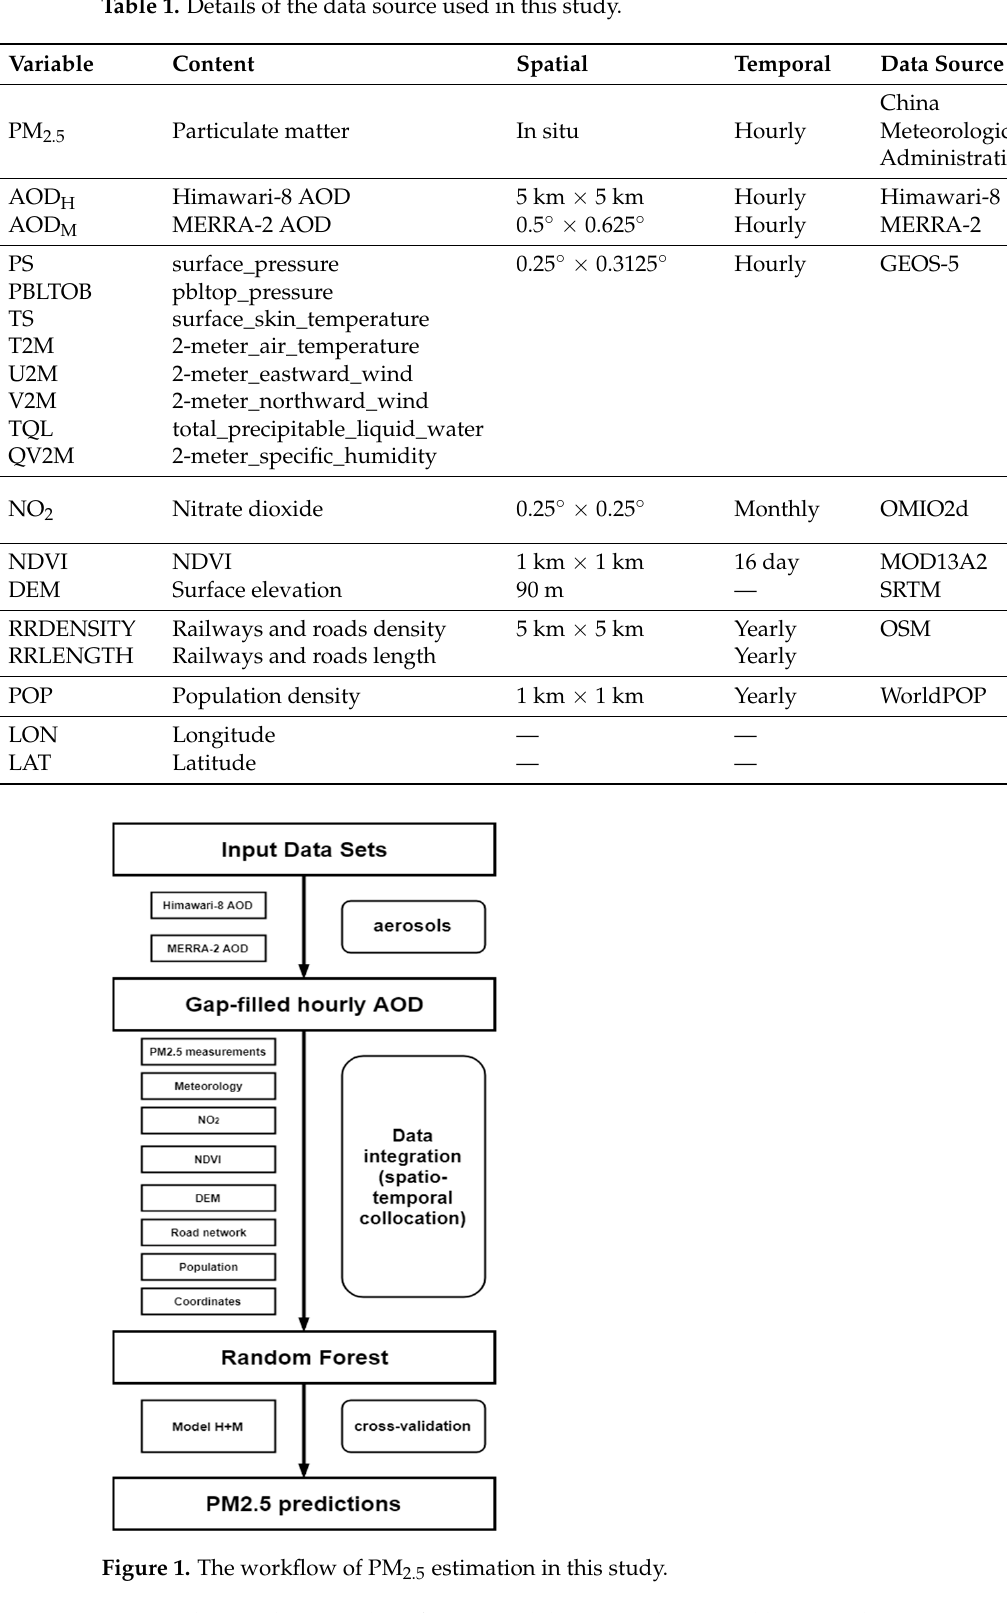
Table 1. Details of the data source used in this study.